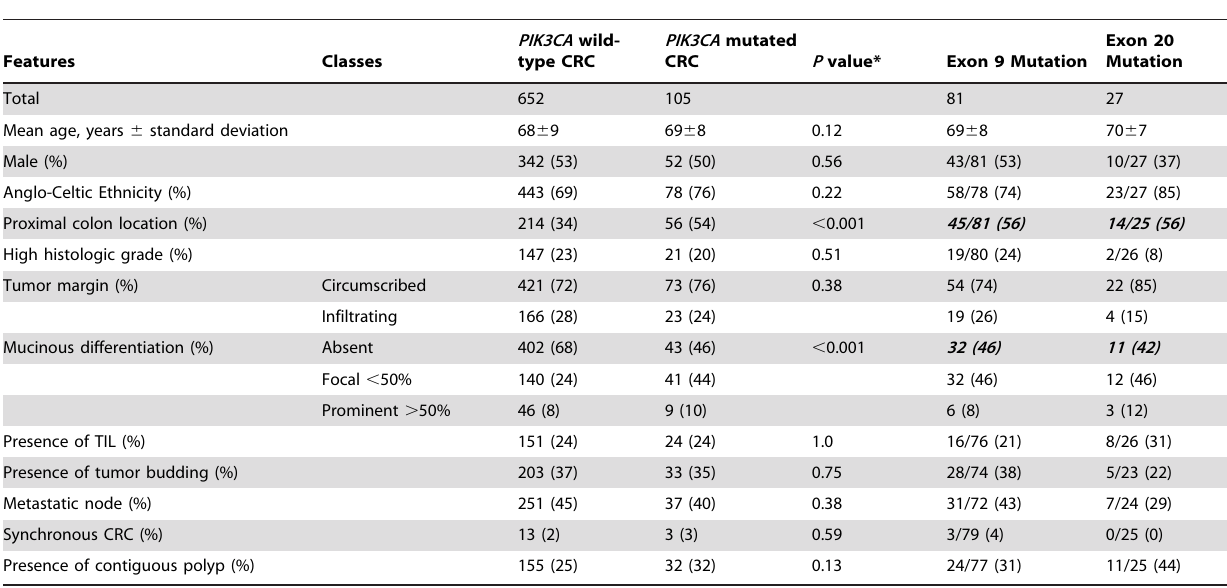
Table 2. PIK3CA mutation in 757 colorectal carcinomas (overall, exon 9 and exon 20 hot spots) and clinico-pathologic features.